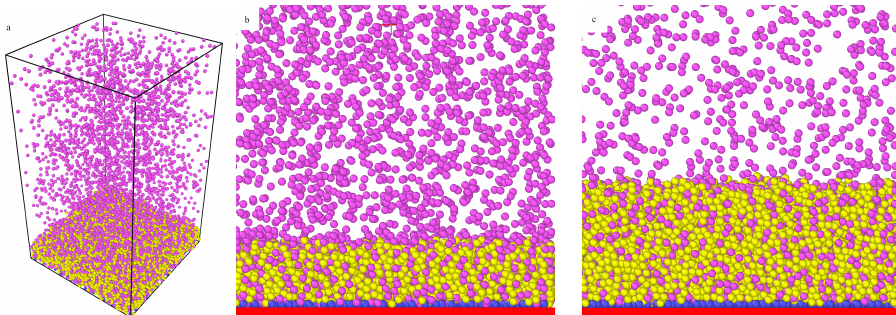
Figure 6. Examples of the equilibrium configurations of the system (M1) involving flat surfaces modified with chains of different lengths: M = 10 ( a , b ) and M = 20. Other parameters: ρ gr = 0.398, ε Ps = 1.5 ε . The red line represents the flat substrate. Blue spheres correspond to bonding segments, yellow spheres and pink spheres represent the remaining segments and fluid particles P, respectively. In parts ( b , c ), sideways views of simulation boxes are